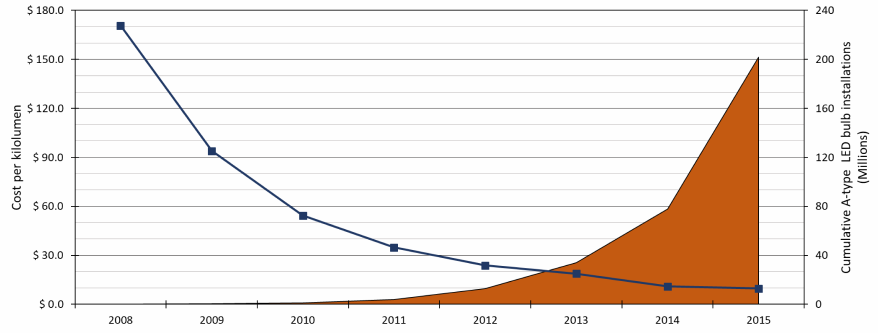
Figure 1. Annual change of LED cost per kilolumen (blue line, left axis) and installations of A-type LED bulbs (orange area, right axis) in the USA. Figure adapted from [14] with